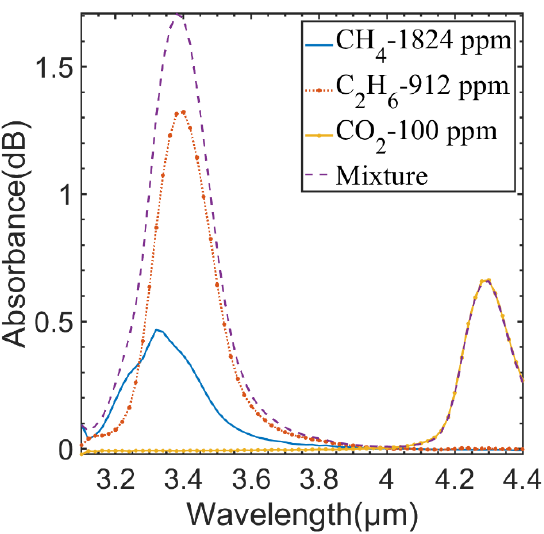
Figure 3. Measured absorption spectra of CH 4 , C 2 H 6 , and CO 2 by the FPI sensing system.